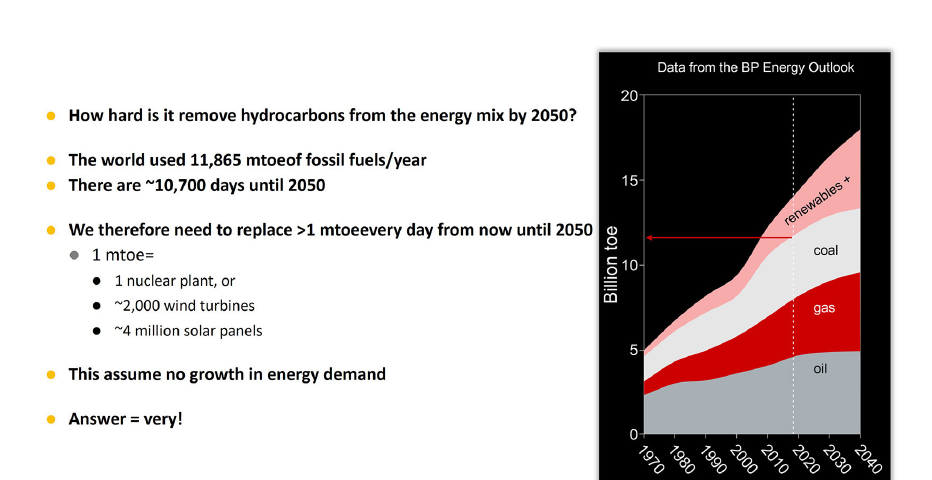
Fig. 19. – How hard is it to remove hydrocarbons from the energy mix by 2050? (Courtesy of Mike Simmons, Halliburton Landmark).